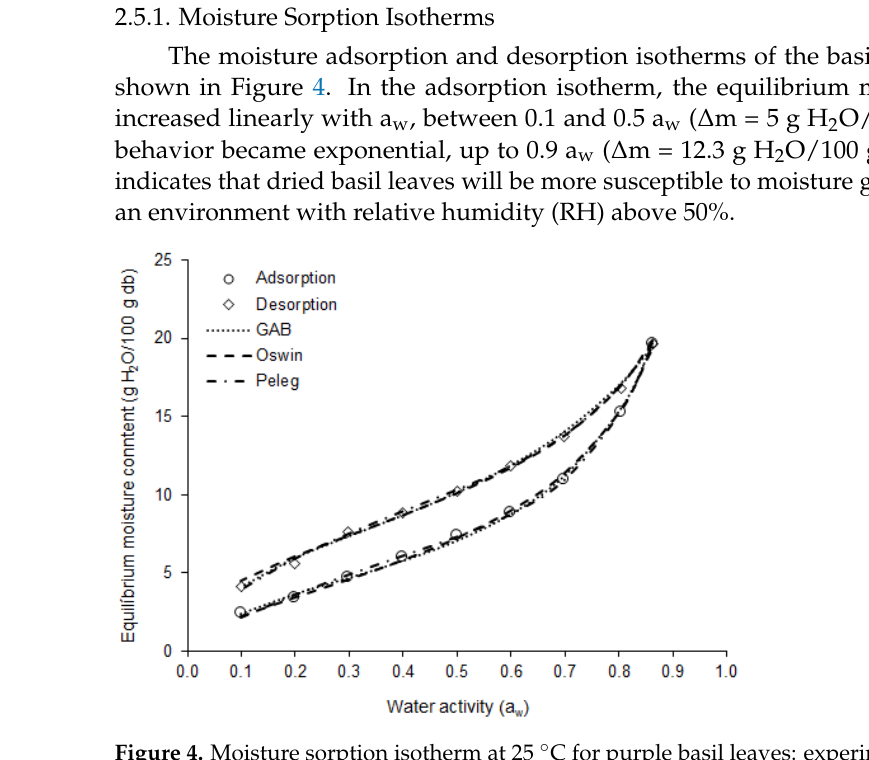
Figure 4. Moisture sorption isotherm at 25 °C for purple basil leaves: experimental data and curves obtained by the GAB, Oswin, and Peleg models.